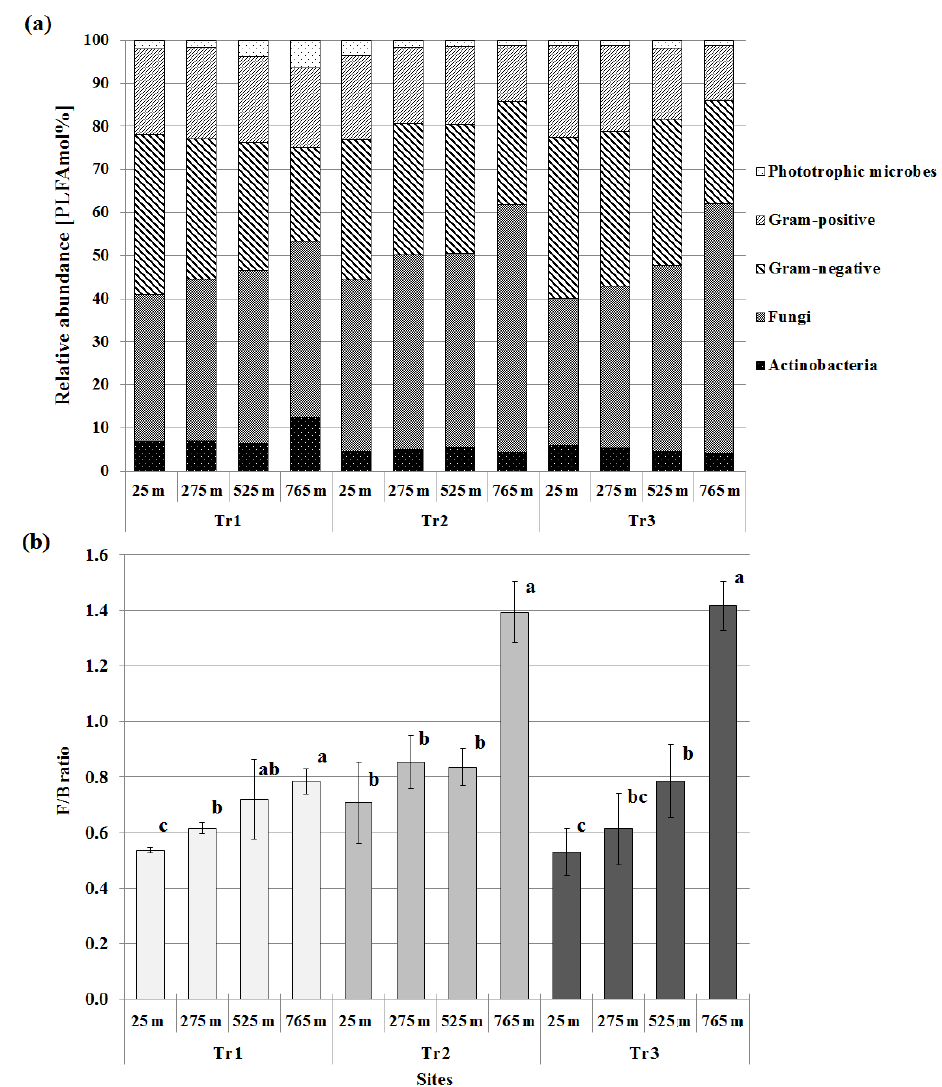
Figure 4. Relative abundance of specific PLFAs within the microbial community (a) and fungi to bacteria ( F/B ) ratios (b) along altitudi- nal transects (Tr1–Tr3). Error bars indicate mean ± SD ( n = 3). Lower case letters denote significant differences between altitudes within particular transects ( P <0.05; one-way ANOVA combined with Tukey post hoc